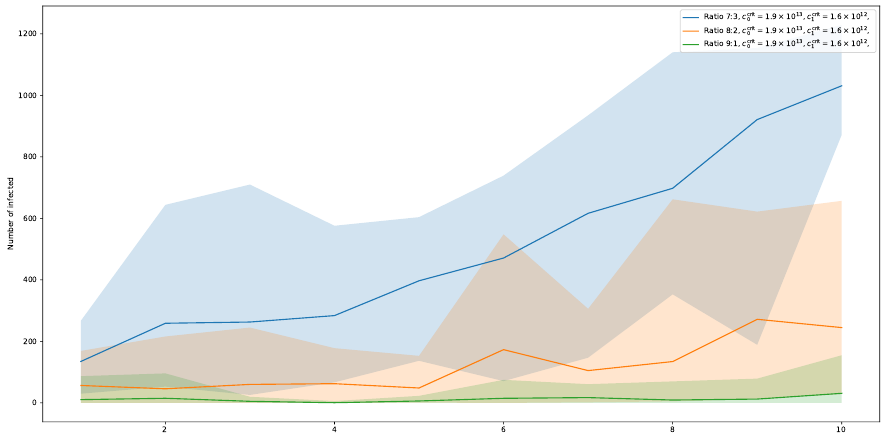
= 1.9 = 1.6 10 13 and c crit 10 12 . In this setting, only the 0 1 × ×